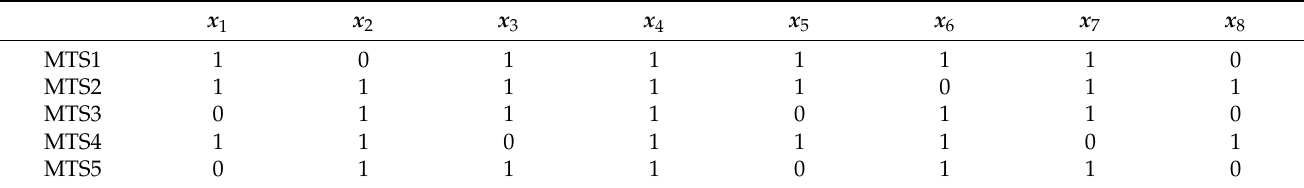
Table 12. Feature variable selection results of BT-MTS of the glass data